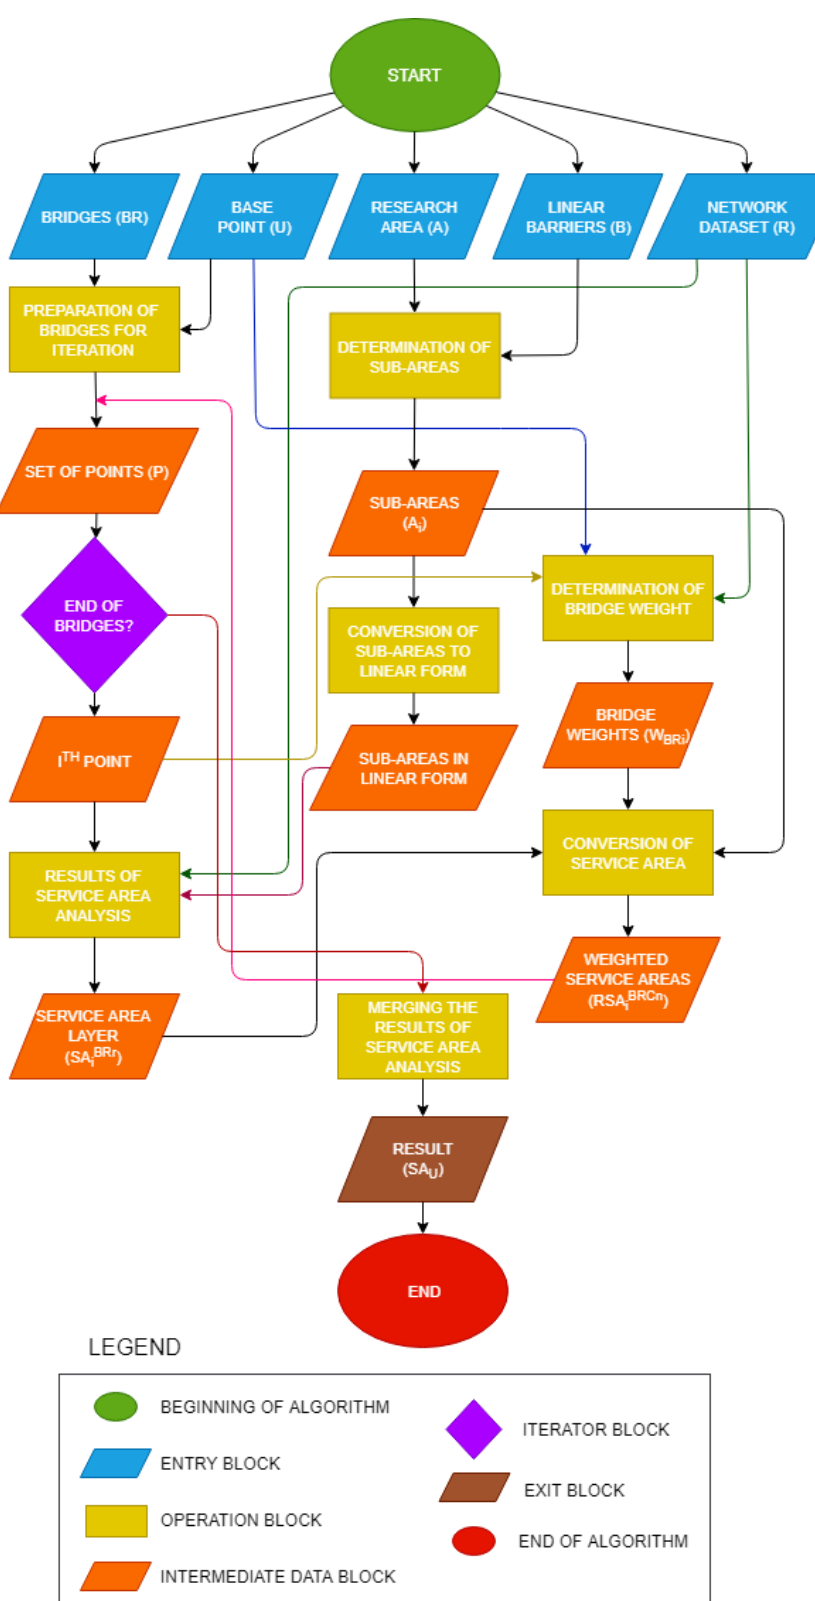
Figure 8. Data processing flow chart in the ModelBuilder application for determining service areas from a single base point in view of linear